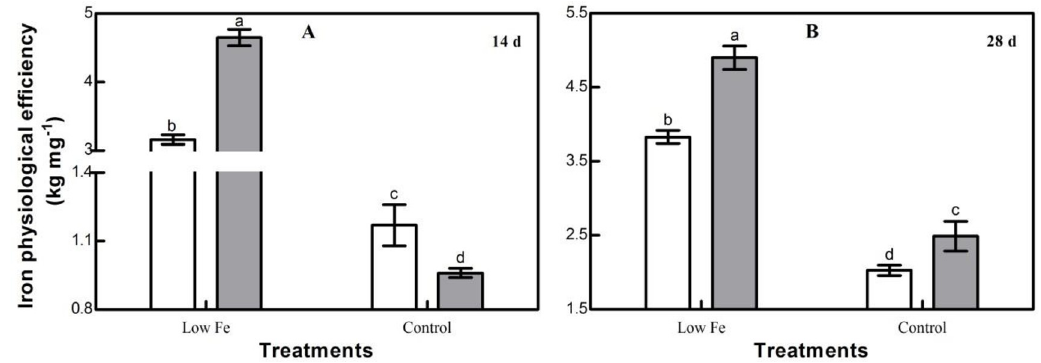
Fig 3. Fe physiological efficiencies of two maize cultivars grown under different Fe concentrations. Data are the mean ± SE of three replicate pots. Values with different lowercase letters are significantly different at p < 0.05.